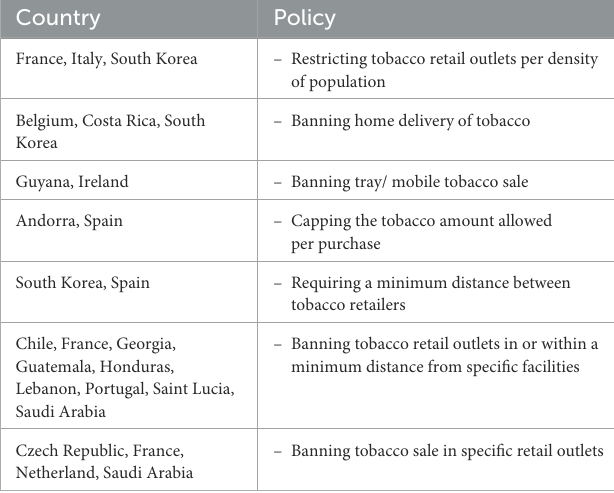
TABLE 2 Policies identified from WHO FCTC Focal Points responses.